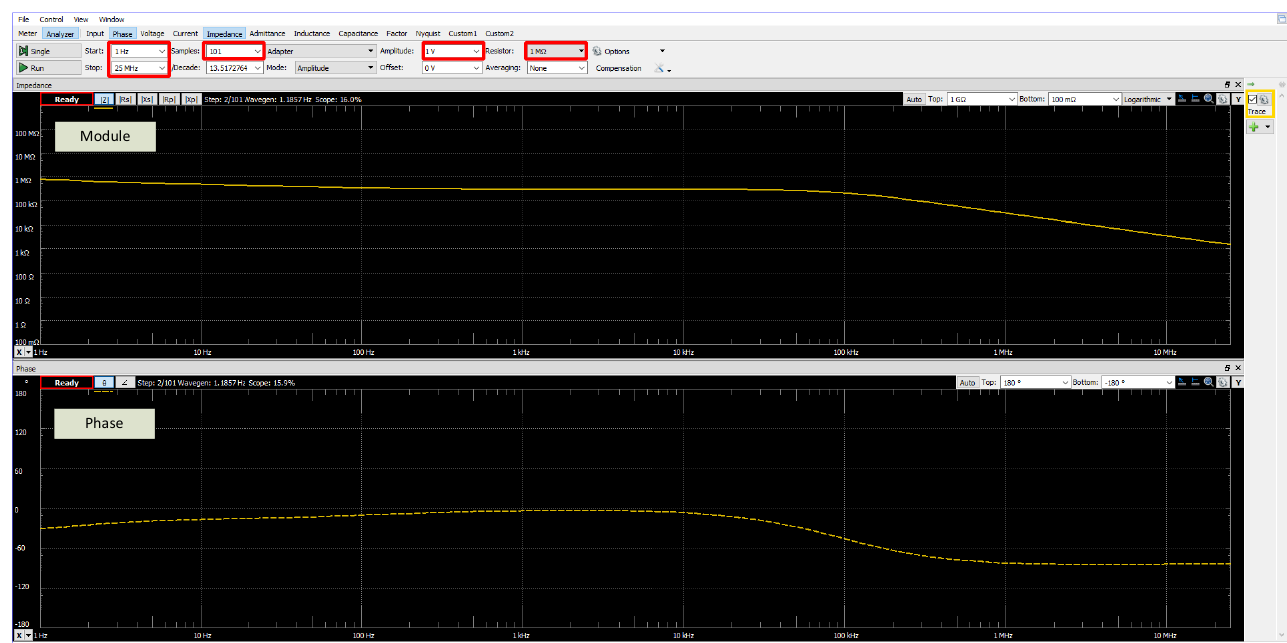
Figure 2. Application configured with a frequency sweep range from 1 Hz to 25 MHz with logarith- mic increment and 101